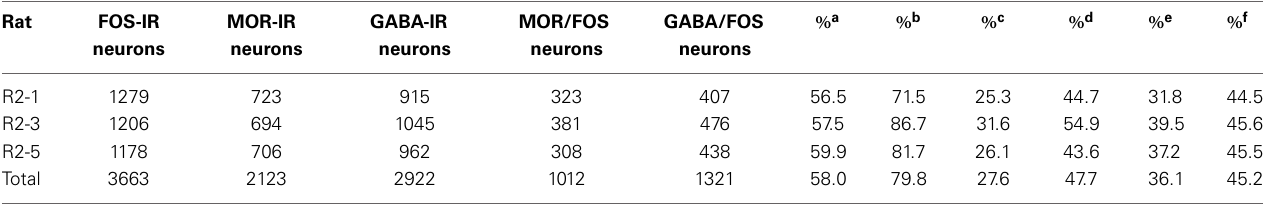
a The percentage of MOR-IR neurons to the total number of FOS-IR neurons; b The percentage of GABA-IR neurons to the total number of FOS-IR neurons; c The percentage of MOR/FOS co-expressing neurons to the total number of FOS-IR neurons; d The percentage of MOR/FOS co-expressing neurons to the total number of MOR-IR neurons; e The percentage of GABA/FOS co-expressing neurons to the total number of FOS-IR neurons; f The percentage of GABA/FOS co-expressing neurons to the total number of GABA-IR neurons.